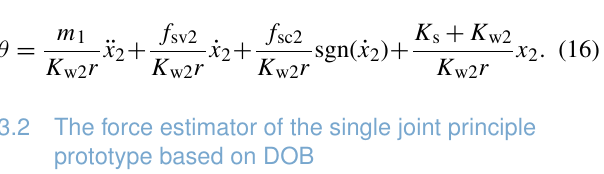
The dynamic model of the gripper joint (part 7) is shown in Eq. (13), where, θ , τ e , m e , J e and r are the gripper joint an- gle, joint driven torque, joint effective mass, joint equivalent moment of inertia, and the effective radius of the cable ten- sion, respectively. τ ef is the friction torque of the joint and is composed of the viscous friction torque and the coulomb friction torque τ ext is the external force moment, and l e is the effective radius of the external force F ext .